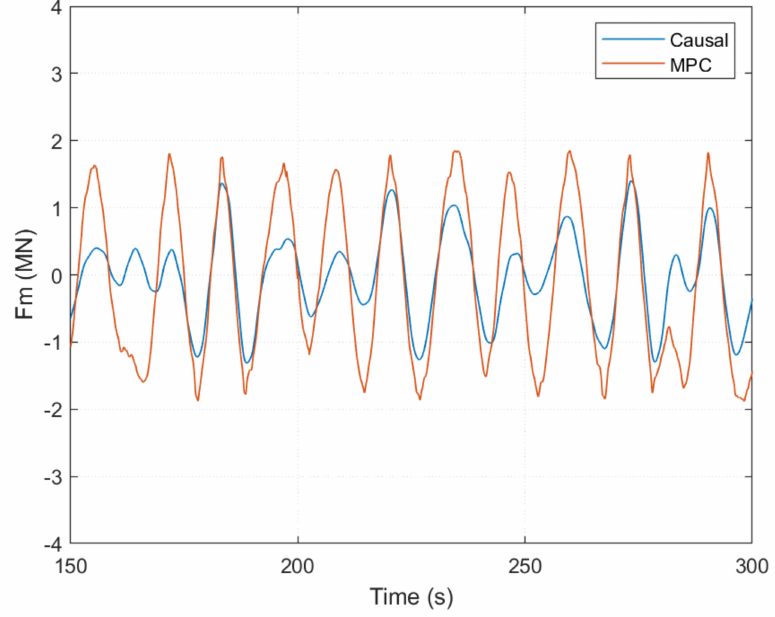
Figure 12. Comparison of PTO force using causal control vs. MPC for an input wave with Hs = 1.0 m, Tp = 15 s.